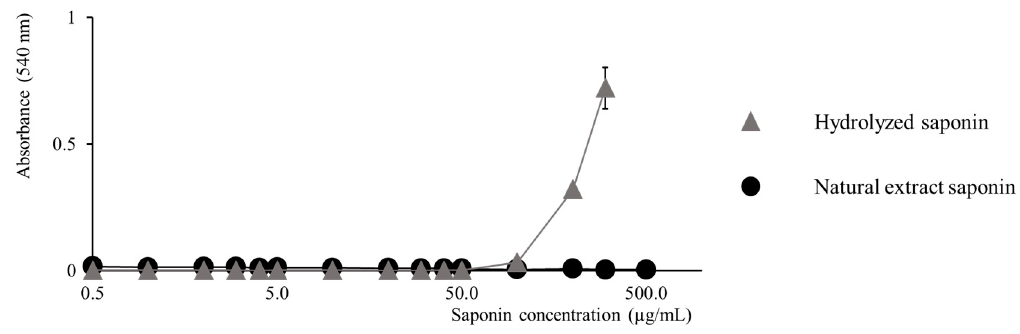
Figure 12. Estimation of the membranolytic property of the natural and hydrolyzed saponins via the hemolytic activity assay. Monitoring the free heme absorbance (540 nm) with regards to the increasing saponin concentration. Hydrolyzed saponins appear to be more cytotoxic than the non-hydrolyzed ones. Hemolytic activity experiments were performed in triplicates and the average data as well as the standard deviations are gathered in Table S1.